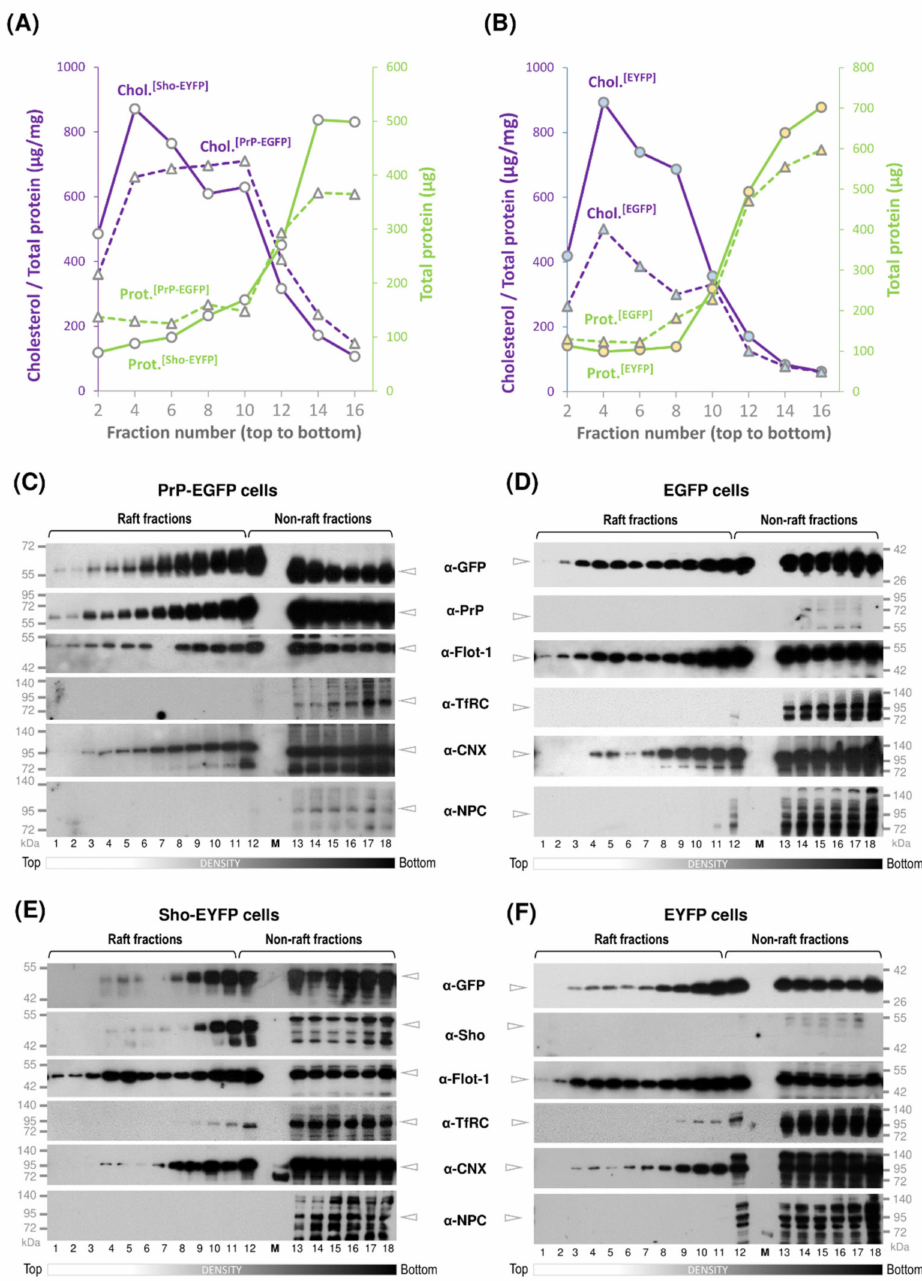
Figure 3. Characterization of membrane fractions and the distribution of the prion and Shadoo proteins across the various density membrane domains obtained by non-detergent based fractionation method. ( A , B ) Distribution of total proteins (left Y -axis) and cholesterol (right Y -axis) in the fractions collected from top to bottom of centrifuge tubes and numbered 1 through 18 of the OptiPrep density gradients of Sho-EYFP and PrP-EGFP cells ( A ) and of their control, EGFP and EYFP cells ( B ). ( C – F ) Representative Western blots of the gradient fractions collected from the PrP-EGFP ( C ) and its control EGFP cells ( D ); Sho-EYFP ( E ) and its control EYFP cells ( F ). Fraction numbers are shown below the blots. Samples are immunoblotted for the proteins as indicated. GFP: EGFP or EYFP protein; Flot-1: flotillin-1; TfRC: transferrin receptor protein; CNX: calnexin; NPC: nuclear pore complex